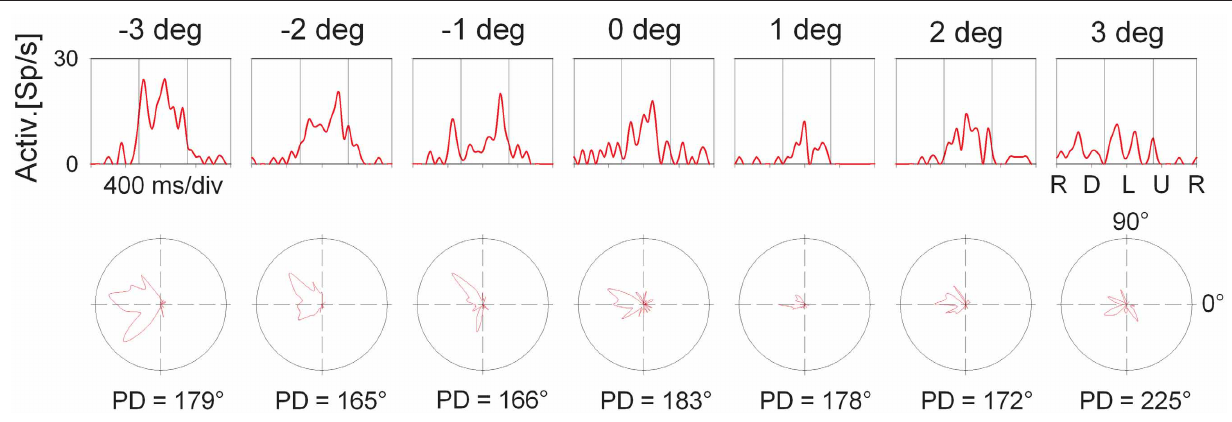
right (R), down (D), left (L), up (U), and again right. The vertical lines indicate the interval which was considered to compute this average discharge. The bottom row shows the same data in polar plots. The preferred directions (PD) are computed based on vector averaging, i.e., weighting each motion direction with the neuron’s discharge for this direction.